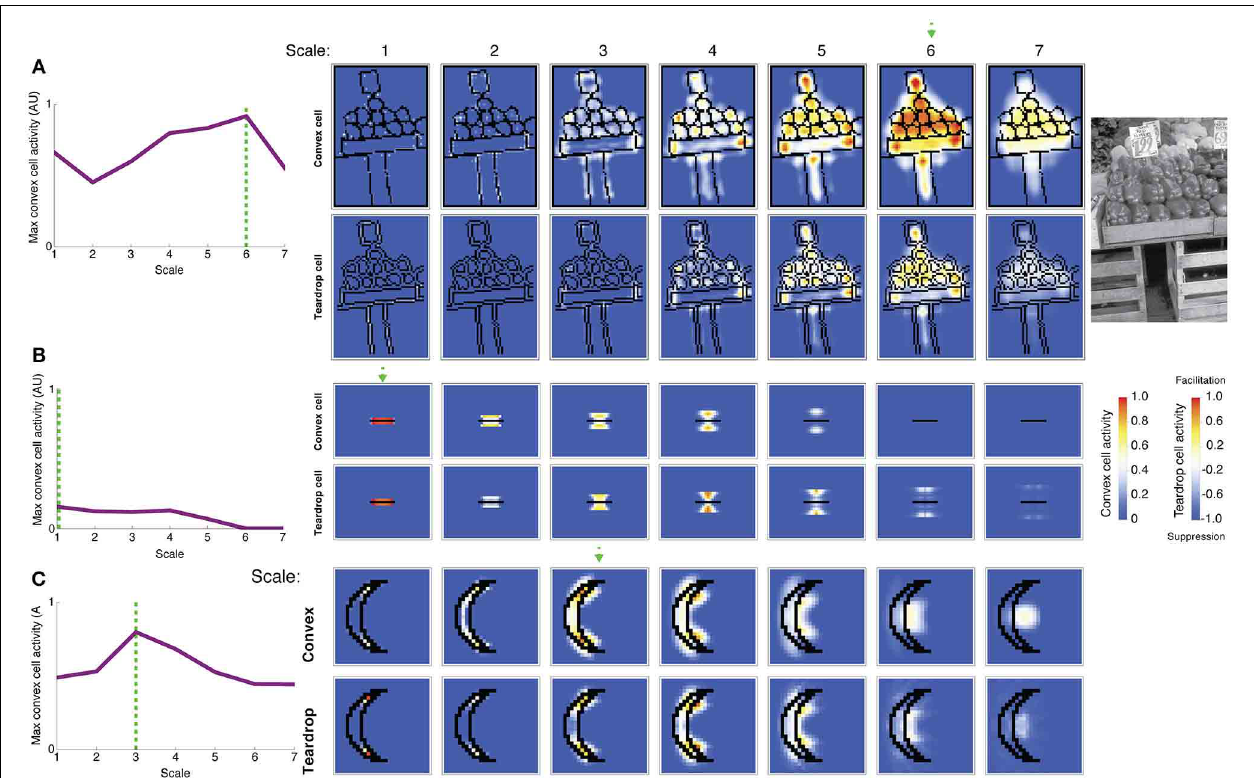
FIGURE 8 | Model simulation of images of a natural scene and a thin bar. The most active convex cells (top rows of panels) signal the position of the figure’s medial axis. The degree of interior enhancement of convex cells due to feedback from teardrop cells is shown in the bottom rows of panels. (A) Simulation of an image of peppers from the Berkeley Segmentation Dataset (right). Convex cells with size 6 RFs (dashed green arrow) yield the maximal response in the center of the pepper figures. (B) Simulation of a bar, which is thinner than the smallest convex cell RF. The most active convex cells are distributed